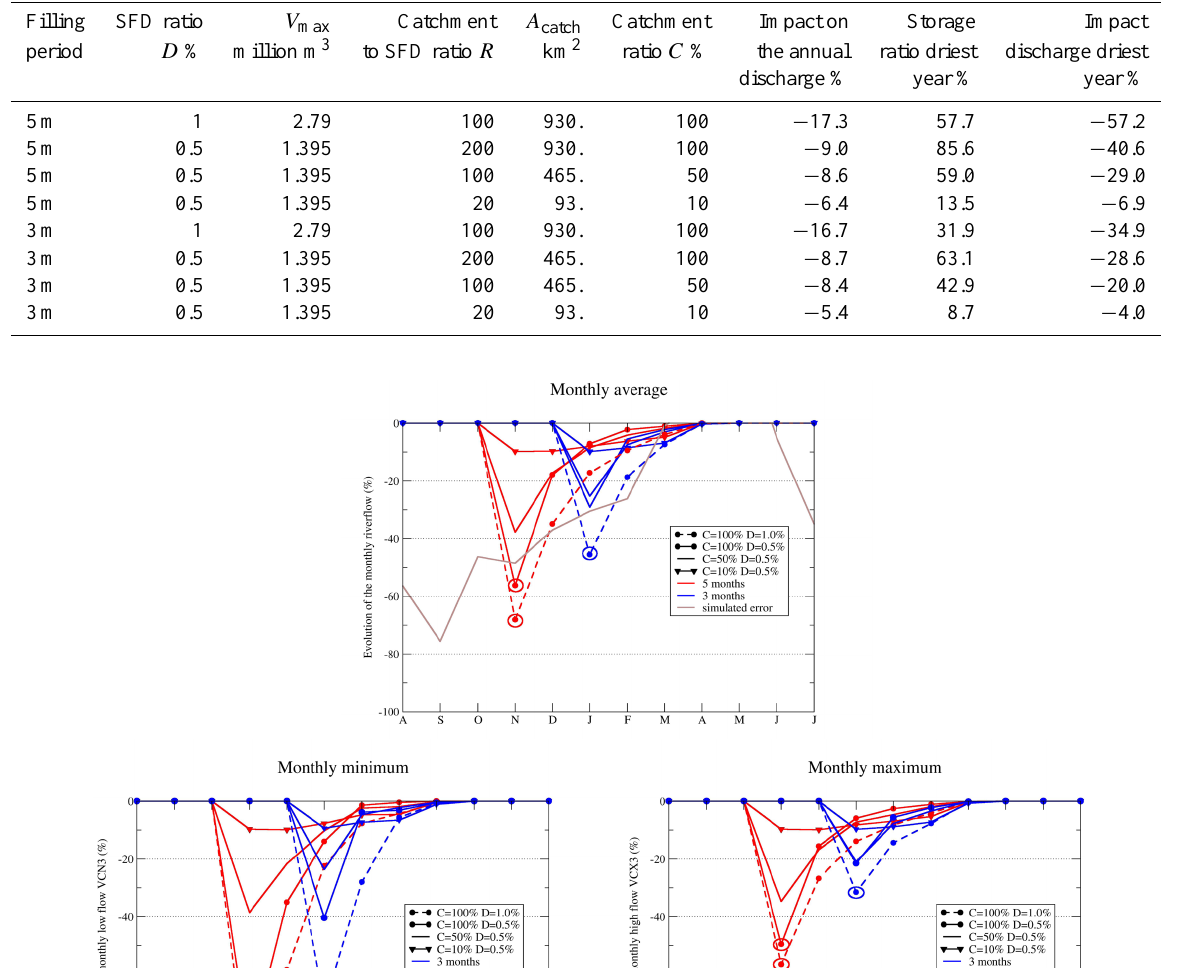
Table 2. SFD properties used to study the impact on the Layon Basin (930km 2 ). The values refer to the entire Layon Basin. The driest year is 1991–1992. The filling periods 5 and 3m stand for the 5 and 3-month periods, respectively.